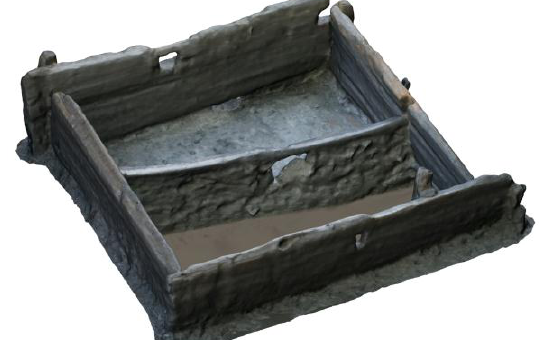
Figure 1. The photo-realistic 3D model of the Bronze Age sluice